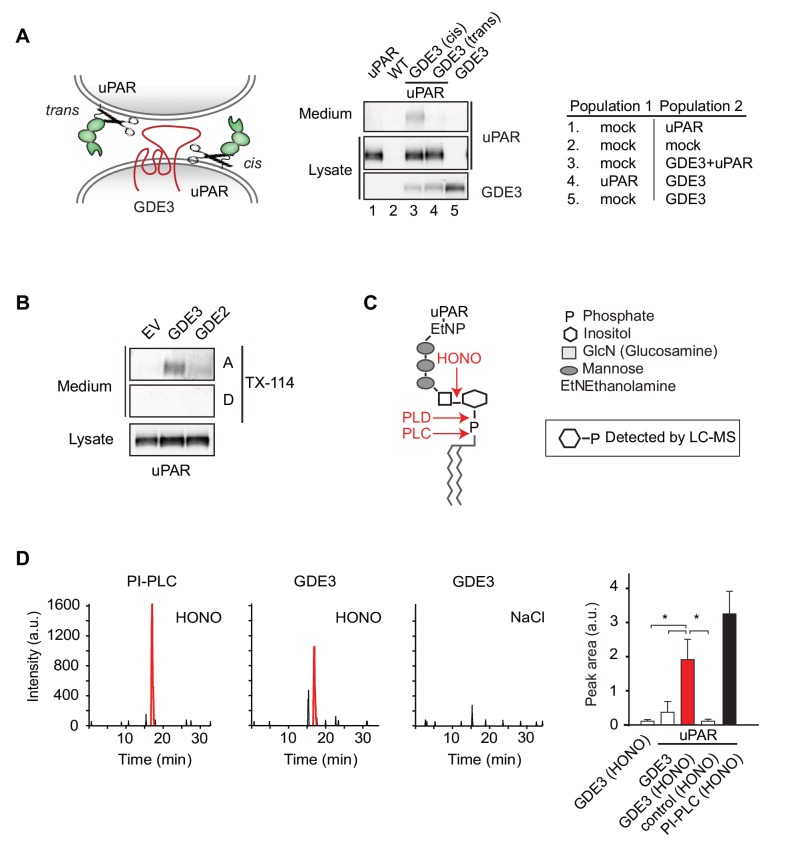
GDE3 is a GPI-specific PLC that cleaves uPAR in cis.(A) (Left) Scheme showing uPAR cleavage in cis or trans. (Right) GDE3-expressing HEK-uPAR cells were mixed with a GDE3-deficient cell population, as indicated. Immunoblot analysis of uPAR in medium and cell lysates indicates that GDE3 acts in cis; mock refers to empty vector-transfected cells. (B) GDE3 expression leads to increased GPI-free suPAR. Conditioned medium from HEK-uPAR cells expressing GDE2 or GDE3 was subjected to Triton X-114 phase separation. suPAR in the aqueous (A) and detergent (D) fractions was analyzed by immunoblotting. (C) GPI-anchor with phospholipase cleavage sites indicated; HONO, nitrous acid. (D) Representative LC-MS ion chromatograms (m/z 259.02–259.03); inositol 1-phosphate peaks in red. HONO-treated suPAR contains inositol 1-phosphate (n = 3, mean ±SEM; *p<0.05).